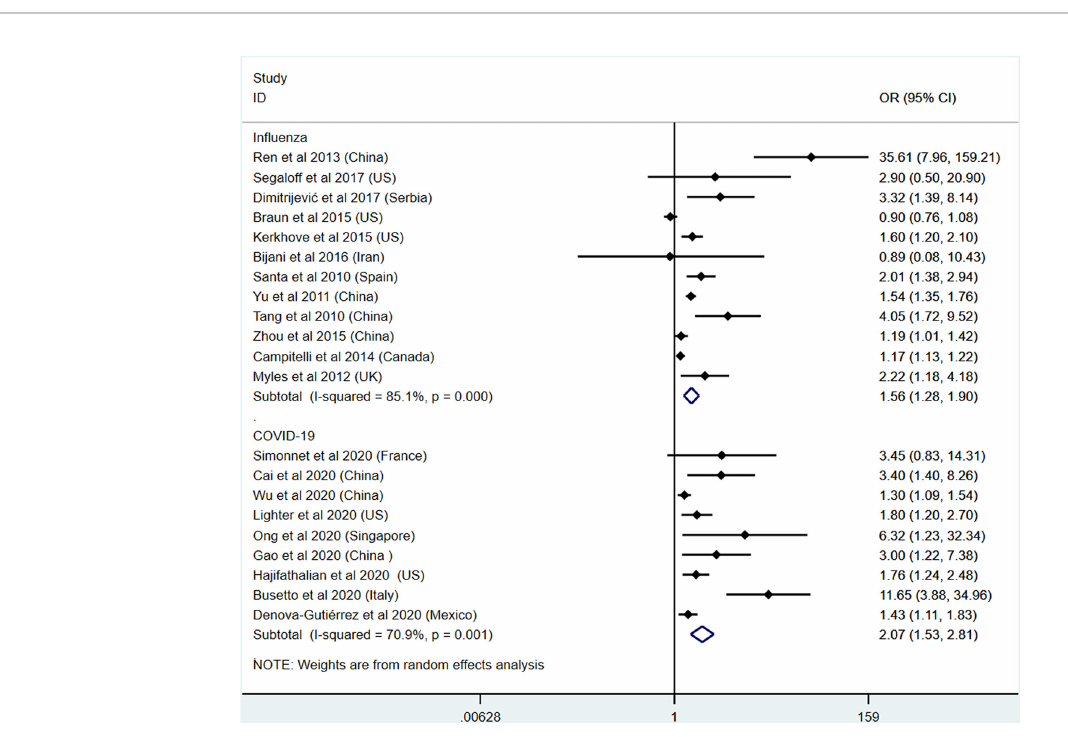
Frontiers in Endocrinology |